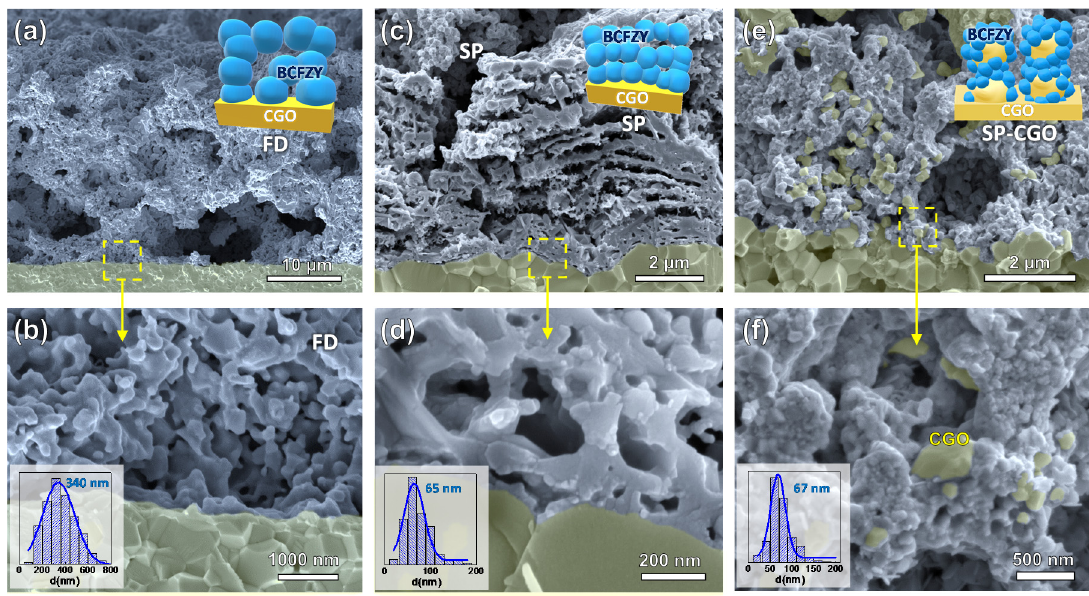
Figure 2. Scanning electron microscopy (SEM) of the different electrode architectures obtained by ( a , b ) freeze-drying and spray-pyrolysis deposition onto ( c , d ) polished CGO and ( e , f ) porous CGO backbone. The grain size distributions are included in the insets.